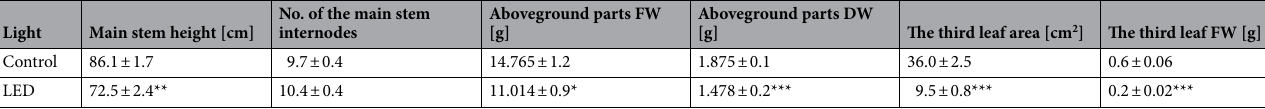
Table 1. Main stem height, fresh (FW), and dry weight (DW) of the aboveground parts (stems with leaves) as well as leaf area of common buckwheat cv. ‘Panda’ grown under different controlled-environment production systems. Control—solar light supplemented with HPS (High-Pressure Sodium) lamps; LED (Light-Emitting Diodes). Values represent means ( n = 10) ± SE. Values marked with stars differ from the control significantly